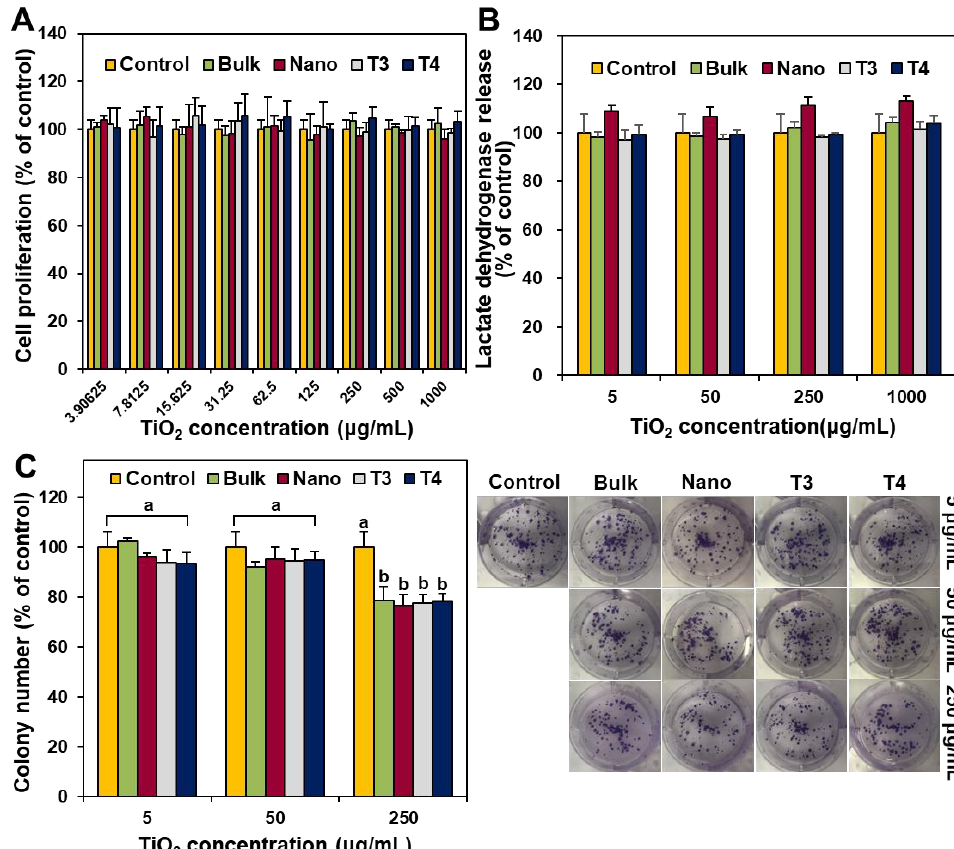
Figure 6. Short-term effect of TiO 2 particles on ( A ) cell proliferation and ( B ) membrane damage of human intestinal Caco-2 cells after 24 h. ( C ) Long-term effect of TiO 2 particles on colony-forming ability of Caco-2 cells after 14 days. Different lowercase letters (a,b) indicate significant differences among control (cells without particle) and different TiO 2 particles (food-grade T3, T4, general-grade bulk and nano) ( p < 0.05).